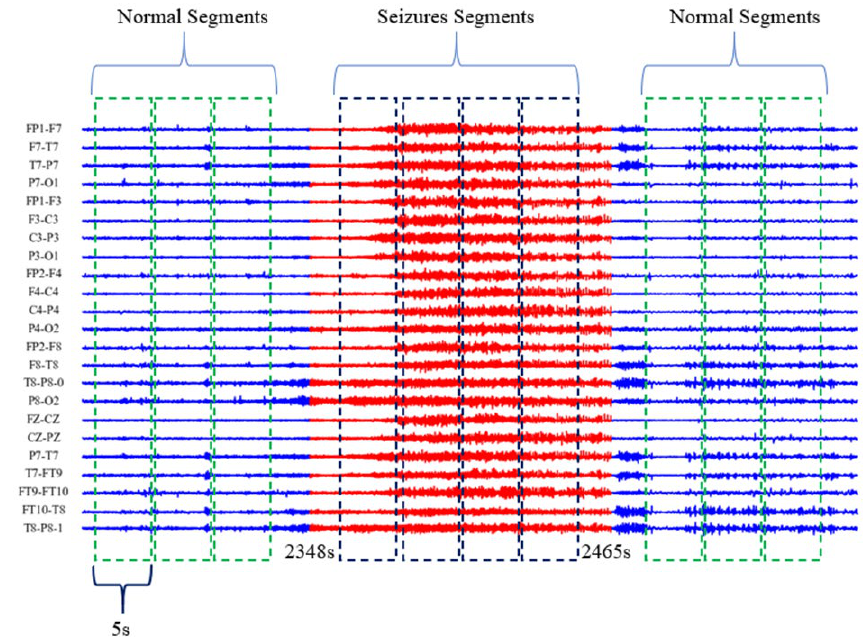
Figure 6. The division of the CHB-MIT data set.